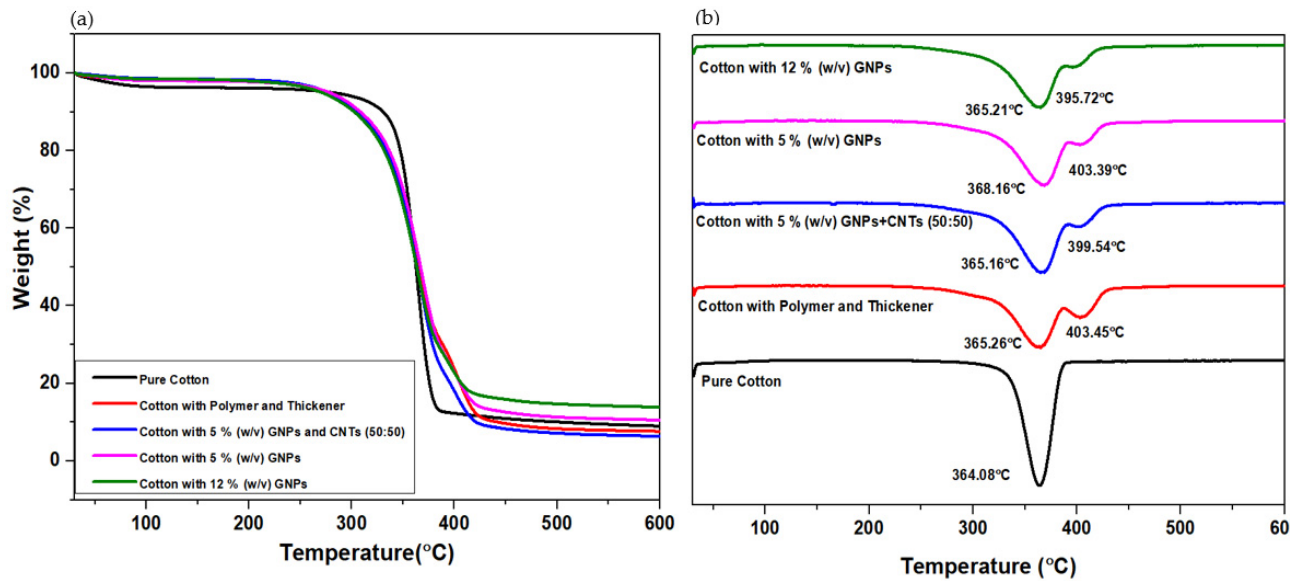
Figure 6. ( a ). TGA weight-loss graphs; ( b ). DTG graphs.